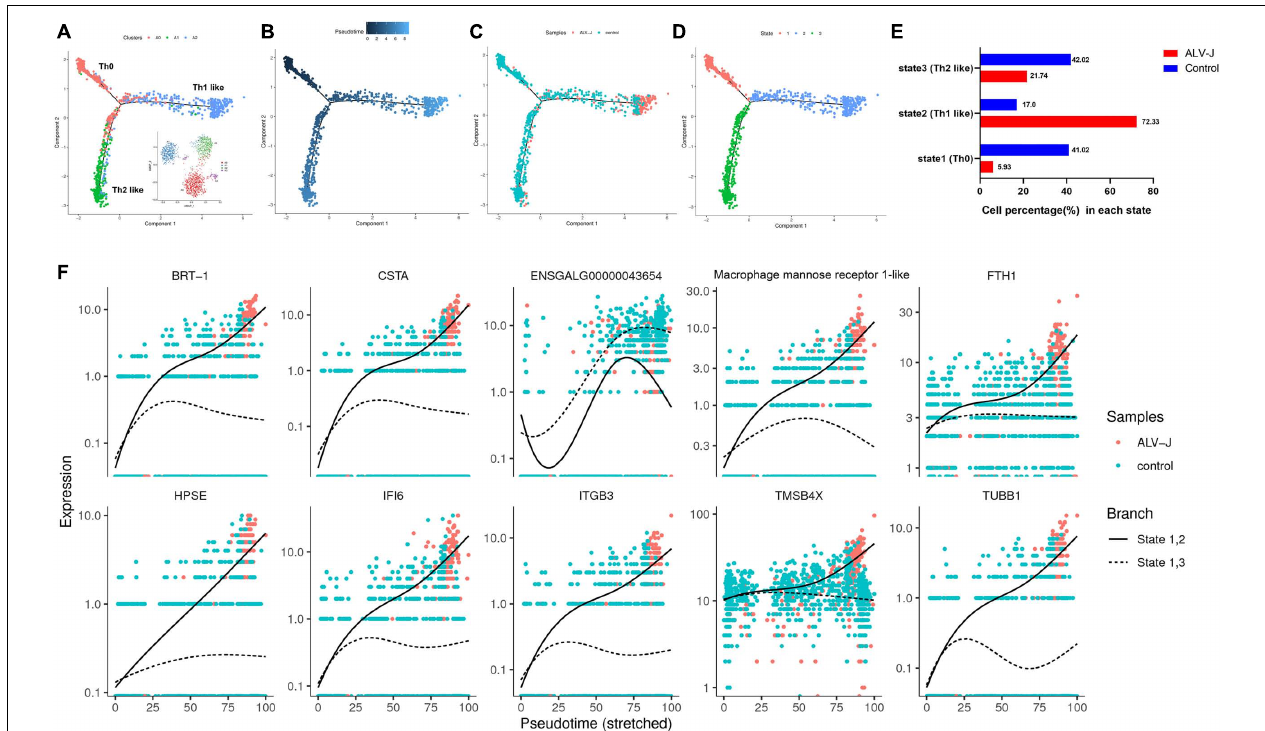
FIGURE 5 | Pseudotime analysis of clusters A0, A1, and A2 . (A) Mapping of clusters A0 (Th0), A1 (Th2-like), and A2 (Thl-like) to the pseudotime trajectory. (B) Pseudotime trajectory calculated from all cells of clusters A0–A2 in the control and ALV-J infected samples. Darker colored dots represent a shorter pseudotime and earlier differentiation period. (C) Mapping of cells in control and ALV-J infected samples to the pseudotime trajectory. (D) The cell states of pseudotime trajectory partitioned from all cells of clusters A0–A2 in the control and ALV-J infected samples. (E) Cell proportion of each state between the ALV-J infected and control samples. (F) Dynamics of the top 10 branching DEGs. Full line: state 1, 2; imaginary line: state 1,